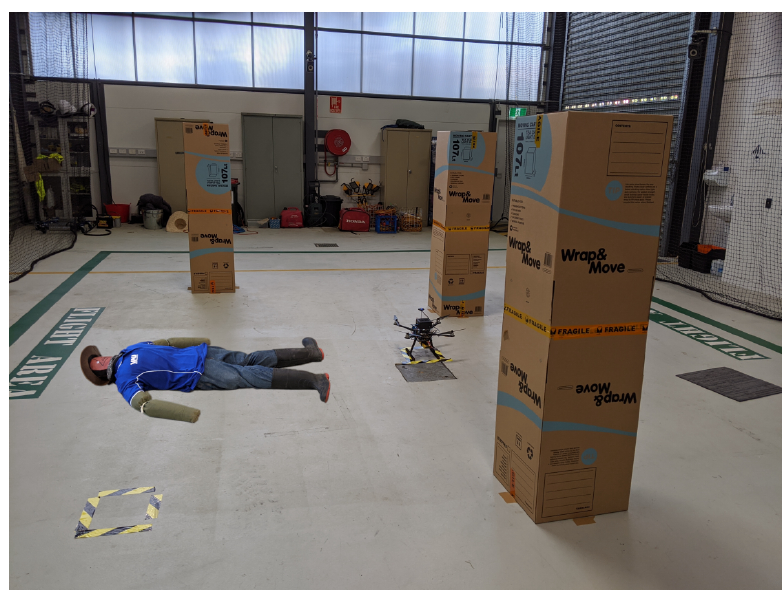
Figure 4. Example of a cluttered indoor environment for UAV Search and Rescue mission. The extent of the free volumetric space area is restricted by randomly placed obstacles. The victim is always lying on the ground and its location is